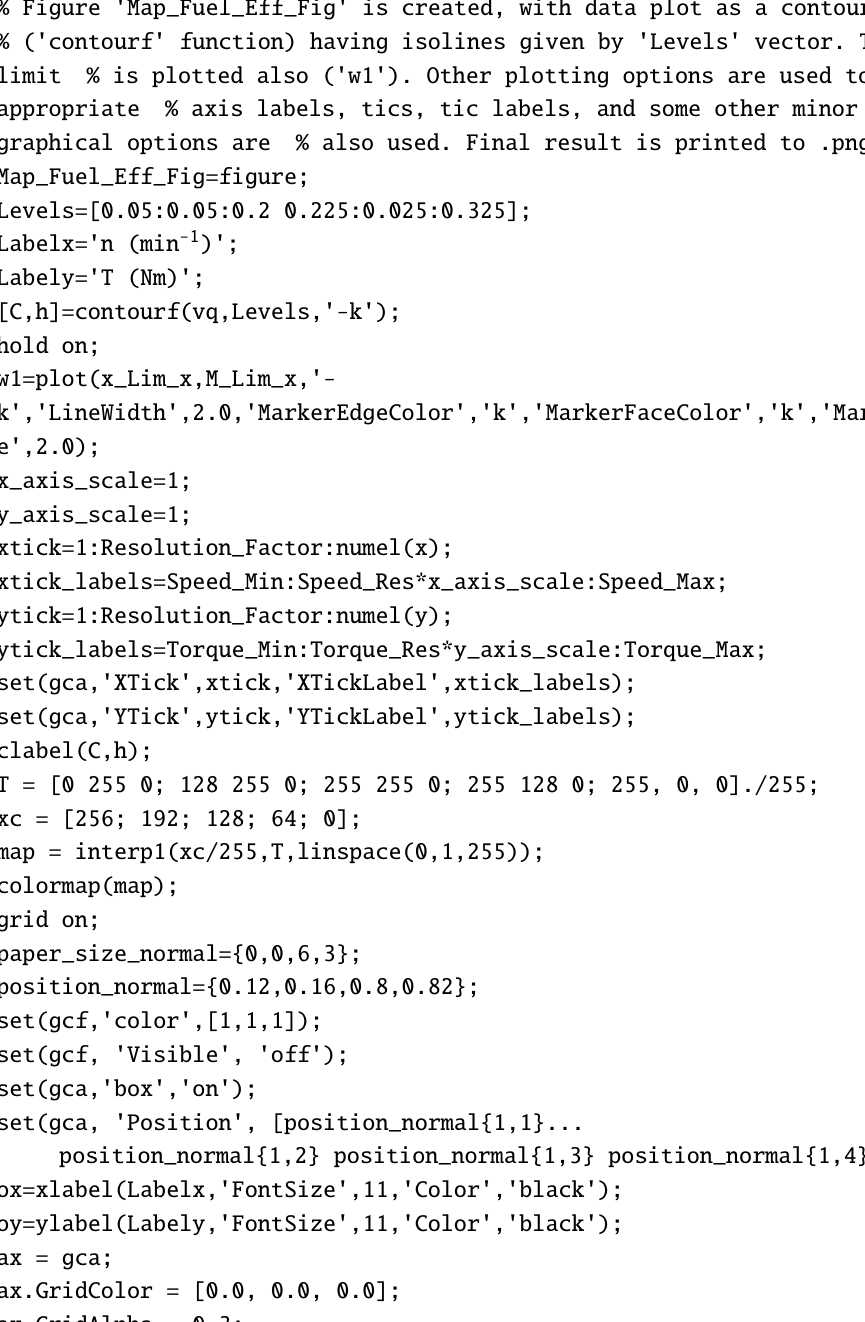
% Figure ' Map_Fuel_Eff_Fig ' is created, with data plot as a contour plot % ( ' contourf ' function) having isolines given by ' Levels ' vector. Torque limit % is plotted also ( ' w1 ' ). Other plotting options are used to set appropriate % axis labels, tics, tic labels, and some other minor graphical options are % also used. Final result is printed to .png